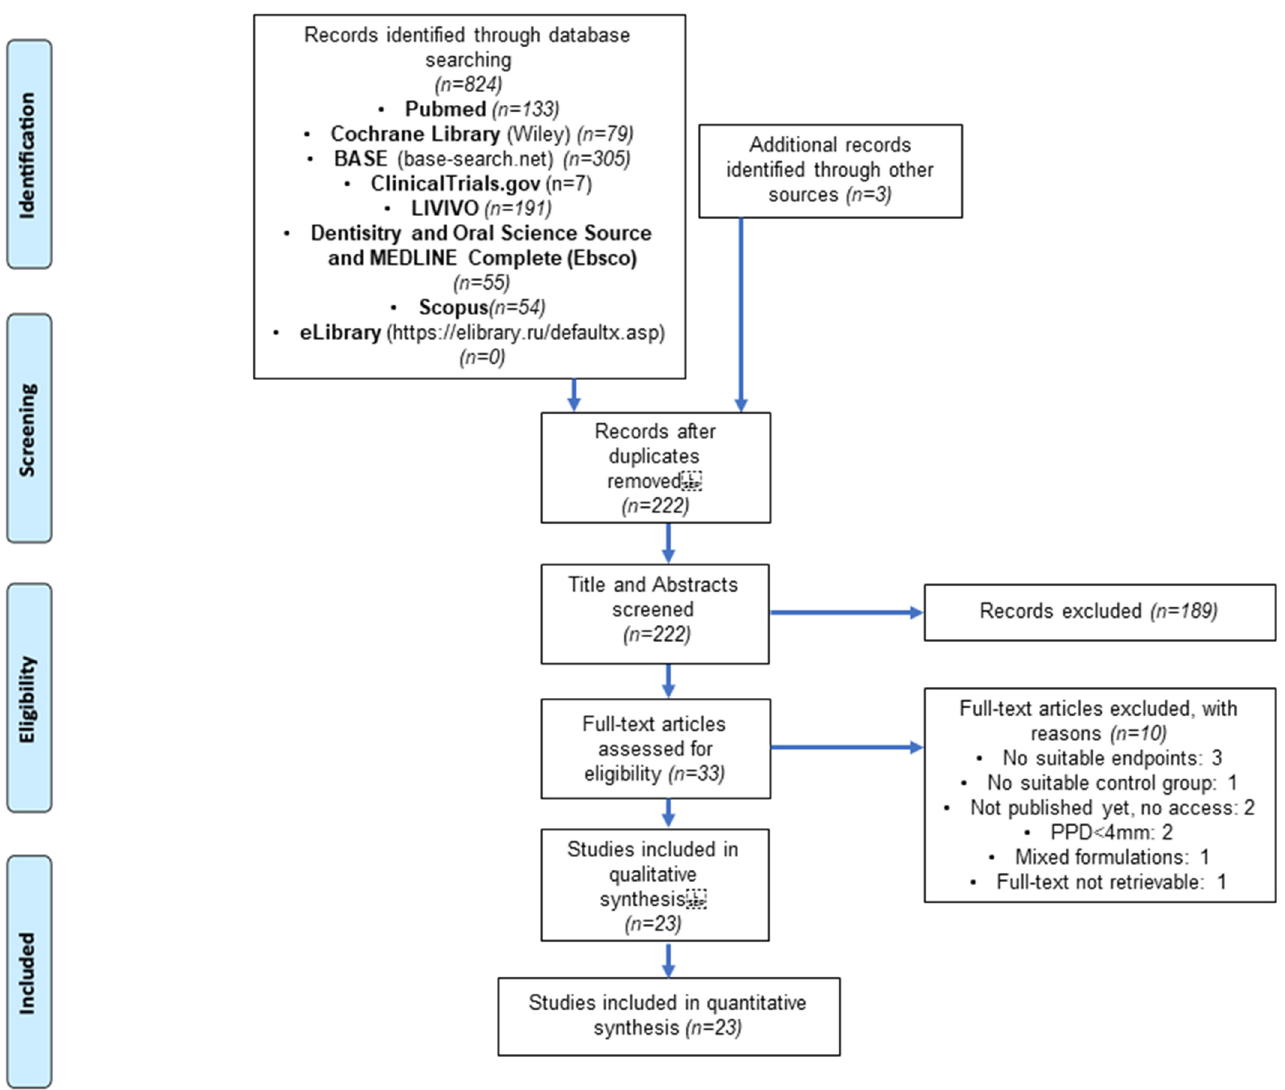
Figure 1. PRISMA Flow Diagram modified from Moher et al. (2009) [60], showing the number of studies identified, screened, assessed for eligibility, excluded, and included in the systematic research [31–53].